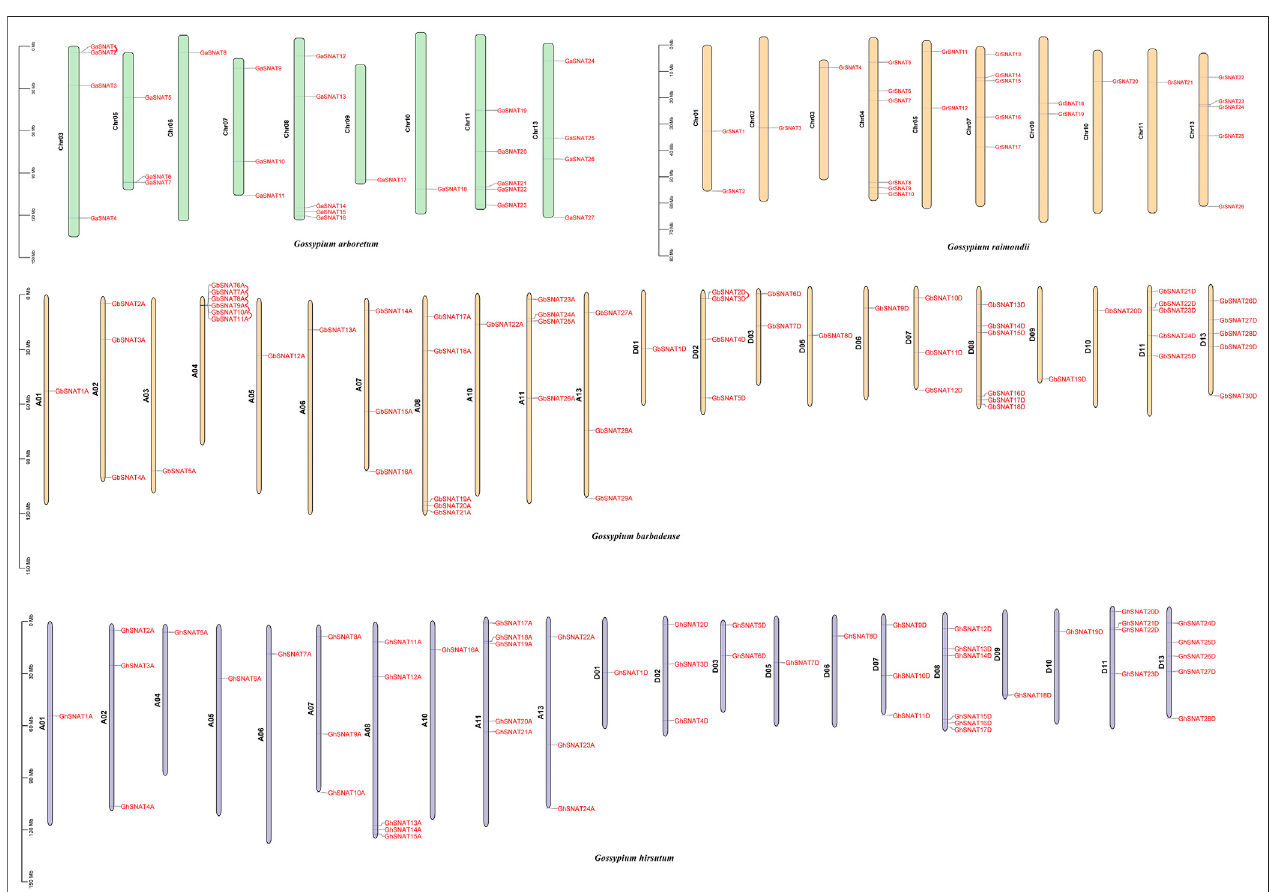
FIGURE 3 | Chromosome localization and gene replication of SNAT s. SNAT s were distributed in Gossypium arboretum , Gossypium Raimondii , Gossypium hirsutum , and Gossypium barbadense , and tandem repeats occurred in the gene pairs connected by wires during